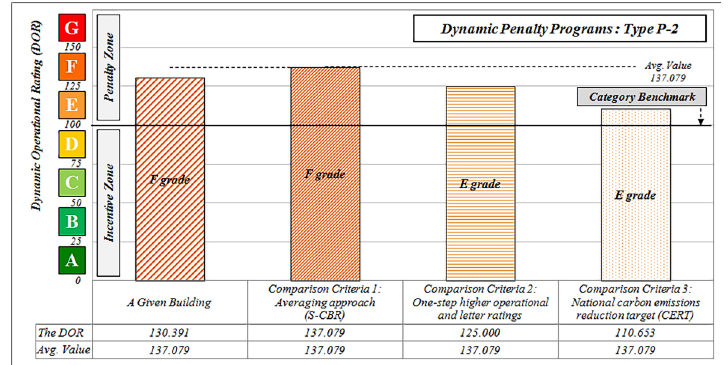
Fig. 2. Comparison chart for the penalty programs (the operational